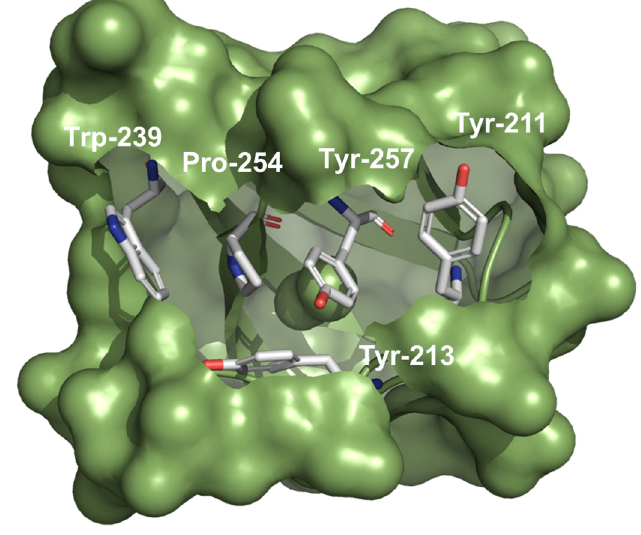
Figure 4. LASP1-SH3 domain. Coulombic surface presentation of the LASP1-SH3 domain illustrating a negatively charged cleft and subsequent proline motif binding by conserved aromatic amino acids. The structure (PDB3i35) was designed using PyMol Molecular Graphic System Version 2.5.4 open source software (Schrödinger, LLC, NY, USA): https://pymol.org; accessed on 12 October 2022.